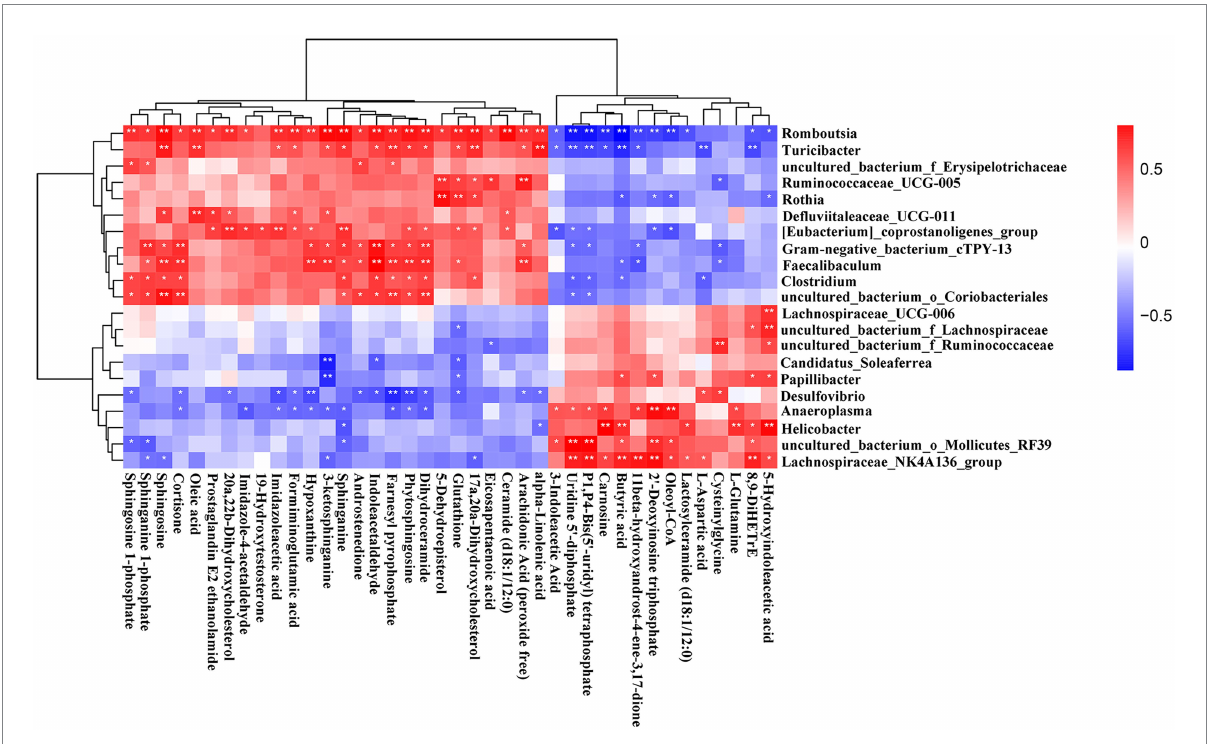
FIGURE 9 Correlation heatmap of differential microbiota and fecal metabolites. Data were calculated by Spearman’s correlation method after mean centering and unit variance scaling. * p < 0.05, ** p <